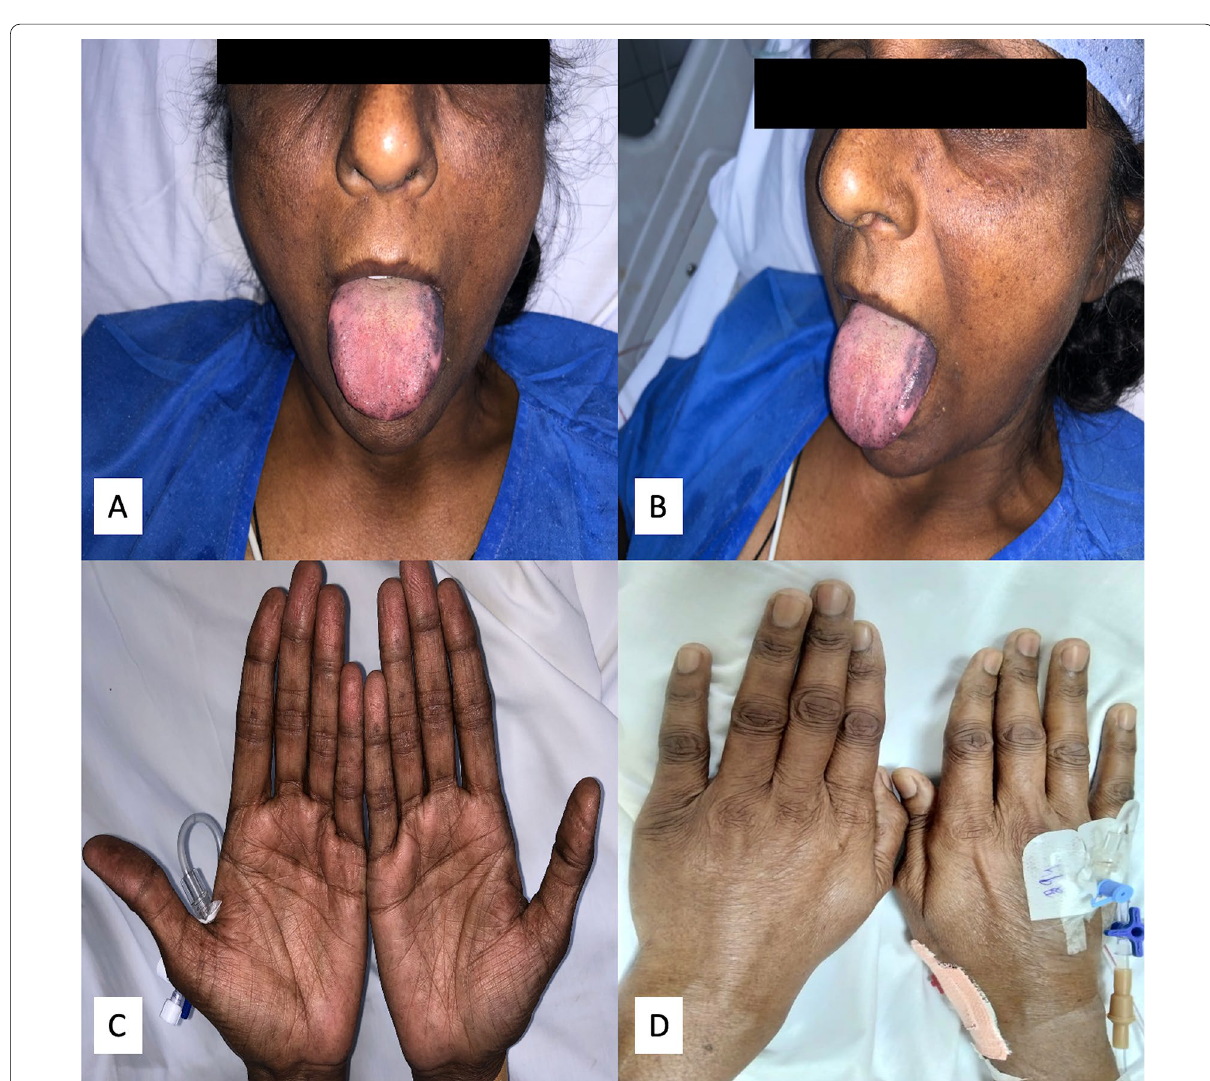
Fig. 1 Clinical pictures of the patient showed the patchy hyperpigmentation over the face and the tongue corresponding to the areas of increased friction ( A , B ). Skin creases and knuckles of both hands also showed hyperpigmentation ( C , D